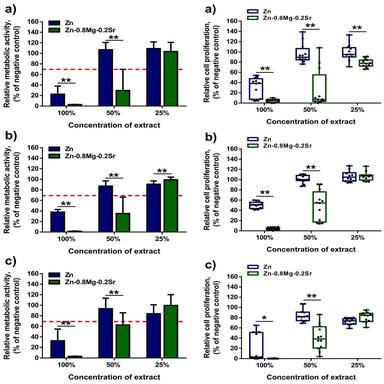
Relative metabolic activities of a) L929 fibroblasts, b) TAg periosteal cells and c) Saos-2 osteoblasts cultured in Zn and Zn-0.8Mg-0.2Sr extracts after incubation for 24 h, detected by CCK-8 assay. The Ti-6Al-4V extracts were used as negative controls and normalized to 100%. The data of three independent experiments are shown as the standard deviations. The red dashed line indicates 70% of negative control, a cut-off between non-cytotoxic and cytotoxic responses. \\ p < 0.01 by an unpaired t-test, compared